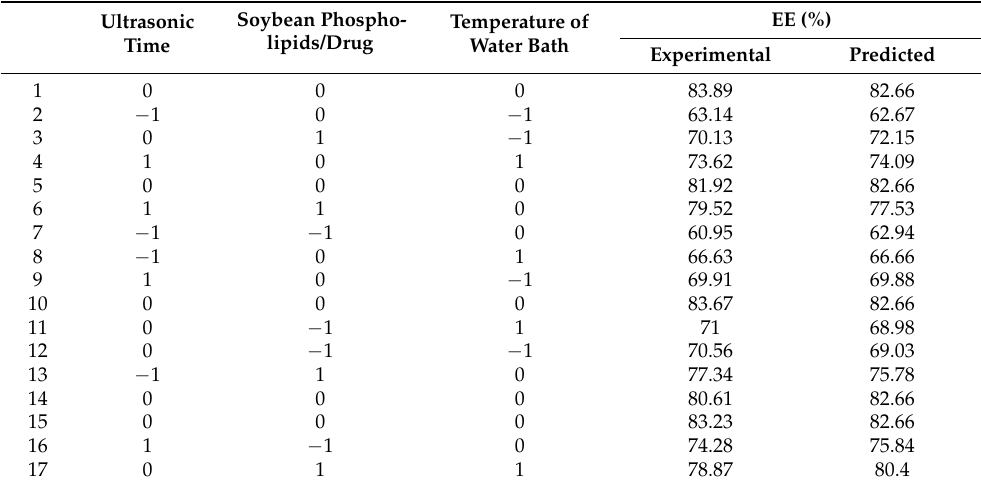
Table 4. BBD design and experimental encapsulation efficiency (%).